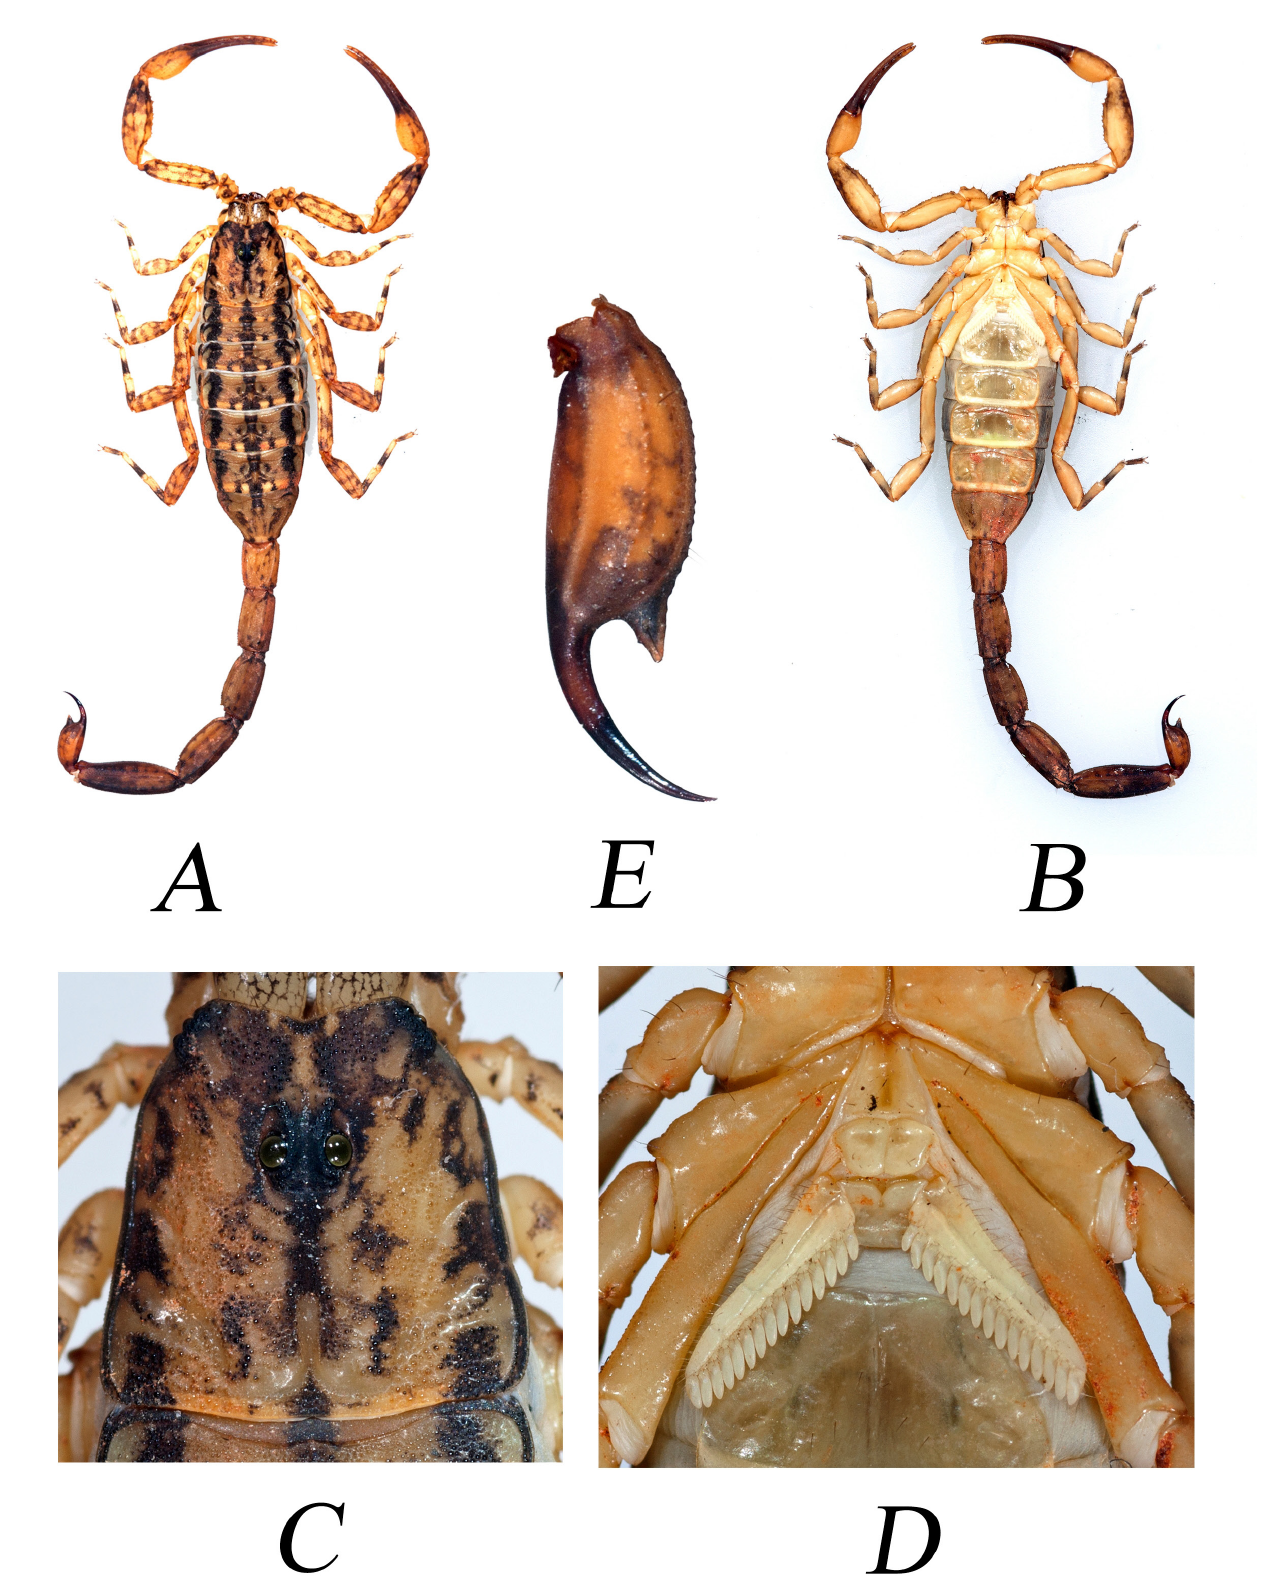
Fig. 16. Isometrus wayanadensis sp. nov., paratype, adult ♀ (BNHS SC 191). A . Dorsal view. B . Ventral view. C . Carapace, dorsal view. D . Sternopectinal area. E . Telson, lateral